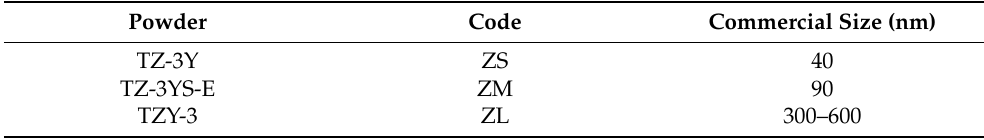
Table 1. Zirconia particle sizes considered in this